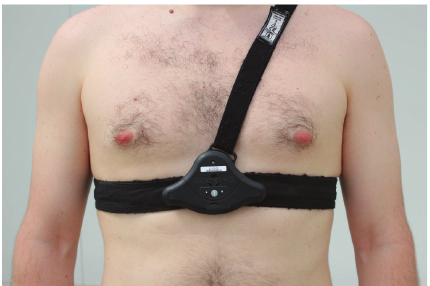
Figure 2: Equivital LifeMonitor device. It comprises the sensor electronics module (SEM) and the monitoring belt. The SEM contains a battery, electronics, and software, in order to process the measurements from the monitoring belt. The monitoring belt holds the SEM onto the body and contains fabric electrodes, which require contact with the user’s skin to measure the body’s vital